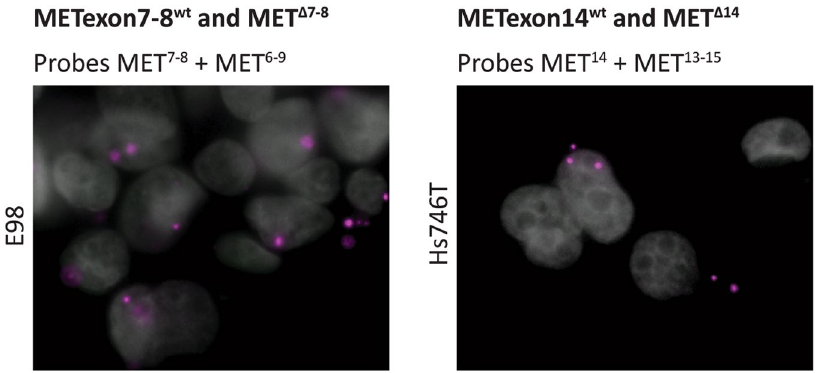
Figure 5. Multi-plex in situ mutation detection of MET using padlock probe rolling circle amplification on cell lines. In situ duo-probe detection of METexon7–8 wt and MET Δ 7-8 transcripts in E98 cells (left) and METexon14 wt and MET Δ 14 transcripts in Hs746T cells (right) using padlock probes MET 7,8 and MET 6–9 , and MET 14 and MET 13–15 , respectively. METexon7–8 wt and METexon14 wt transcripts are displayed as green RCPs, MET Δ 7-8 and MET Δ 14 transcripts are displayed as magenta RCPs. Cell nuclei are shown in grey. Original magnification